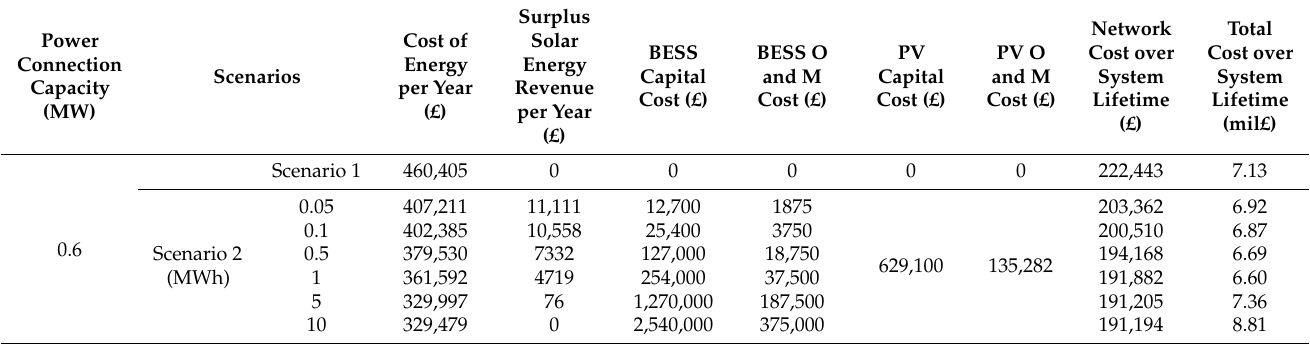
Table 6. System cost at different battery capacities (C BESS ) for scenario 1 and scenario 2.